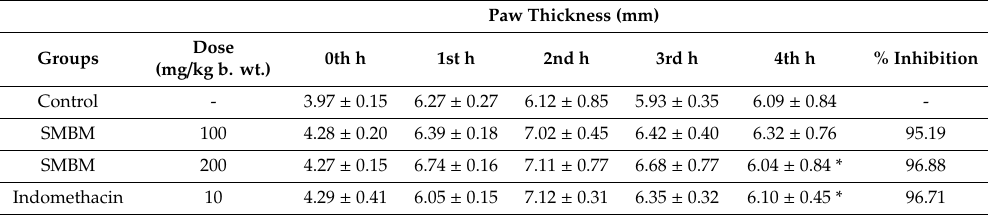
Table 3. Activity of SMBM against carrageenan induced oedema model.